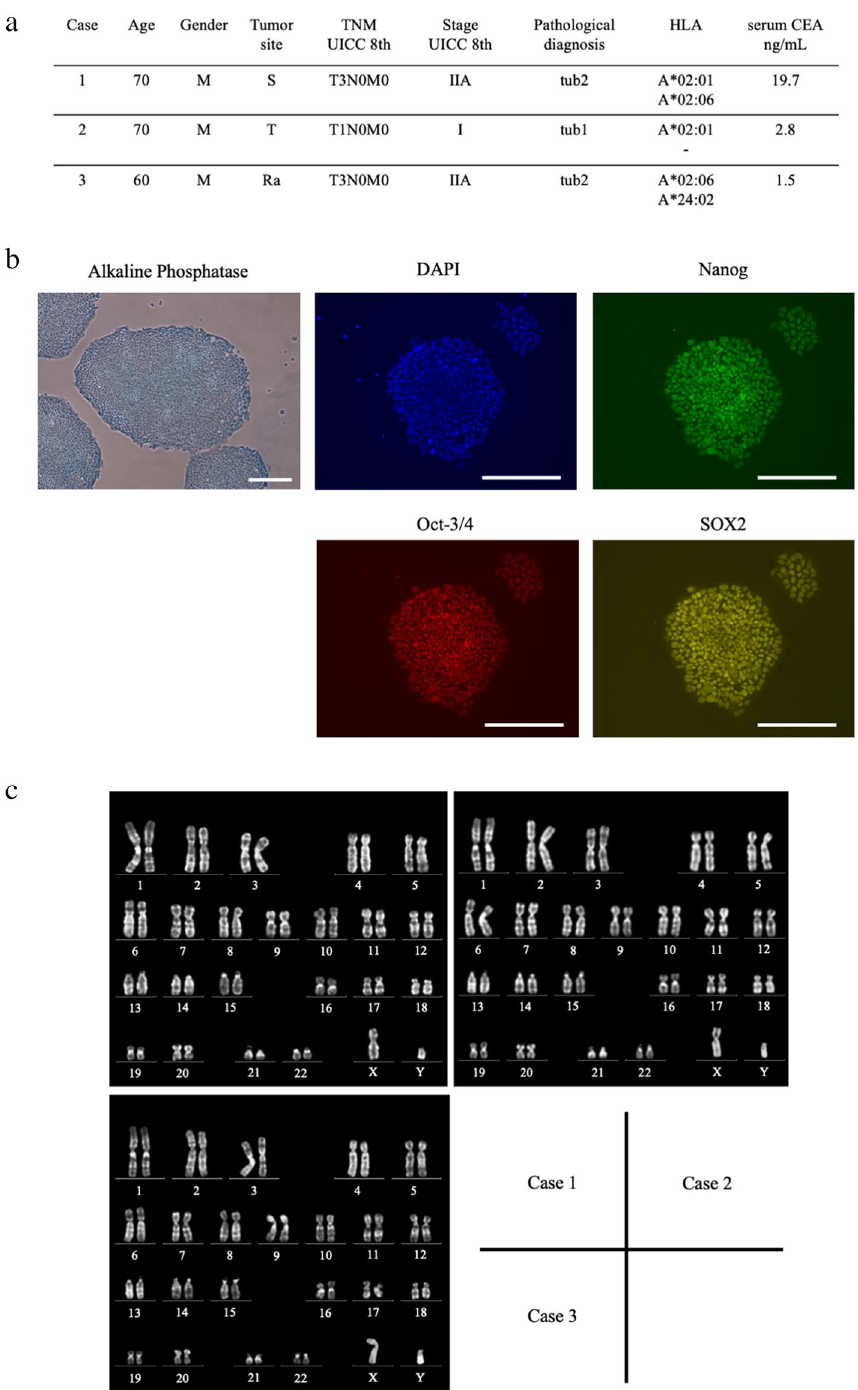
Figure 1. Generation of iPSDCs from patient-derived autologous iPSCs and their cell characterization in comparison to BMDCs. ( a ) List of colorectal cancer samples. The HLA-A allele was determined using an HLA-A High Resolution Typing System. Neoantigen analysis was performed in Case 3. Abbreviation Description S is sigmoid colon, T is transverse colon, Ra is upper rectum, tub1 is well-differentiated adenocarcinoma, and tub2 is moderately-differentiated adenocarcinoma. ( b ) Characterization of autologous iPSCs derived from a patient, Case 1. Alkaline phosphatase staining and fluorescent staining with undifferentiated markers showed pluripotency of iPSCs. Scale bars = 80 μm. ( c ) Karyotyping of iPSCs. No chromosomal abnormalities were found in these chromosomes in Case 1, 2, and 3. ( d ) The schematic diagram of differentiation protocol for iPSDCs. Scale bars = 80 μm (Before Day 16). Scale bars = 20 μm (After Day 21). ( e ) Morphology showing mature BMDCs (left) and mature iPSDCs (right) derived by Case 1. Scale bars = 20 μm. ( f ) Surface phenotypes of BMDCs (left) and iPSDCs (right) derived from the same cancer patient, Case 3. Black-filled histograms represent the staining results of specific antibodies. Gray lines highlight isotype-matched controls. ( g ) The expression of HLA-A on mature iPSDCs and BMDCs. Black-filled highlight the staining results of HLA-A. Gray lines histograms represent the isotype-matched controls. ( h ) The secretion of IFN-γ, IL-12(p70) and TNF-α from BMDCs and iPSDCs was examined by ELISA assay. Data represent the mean ± SD (three donors for each